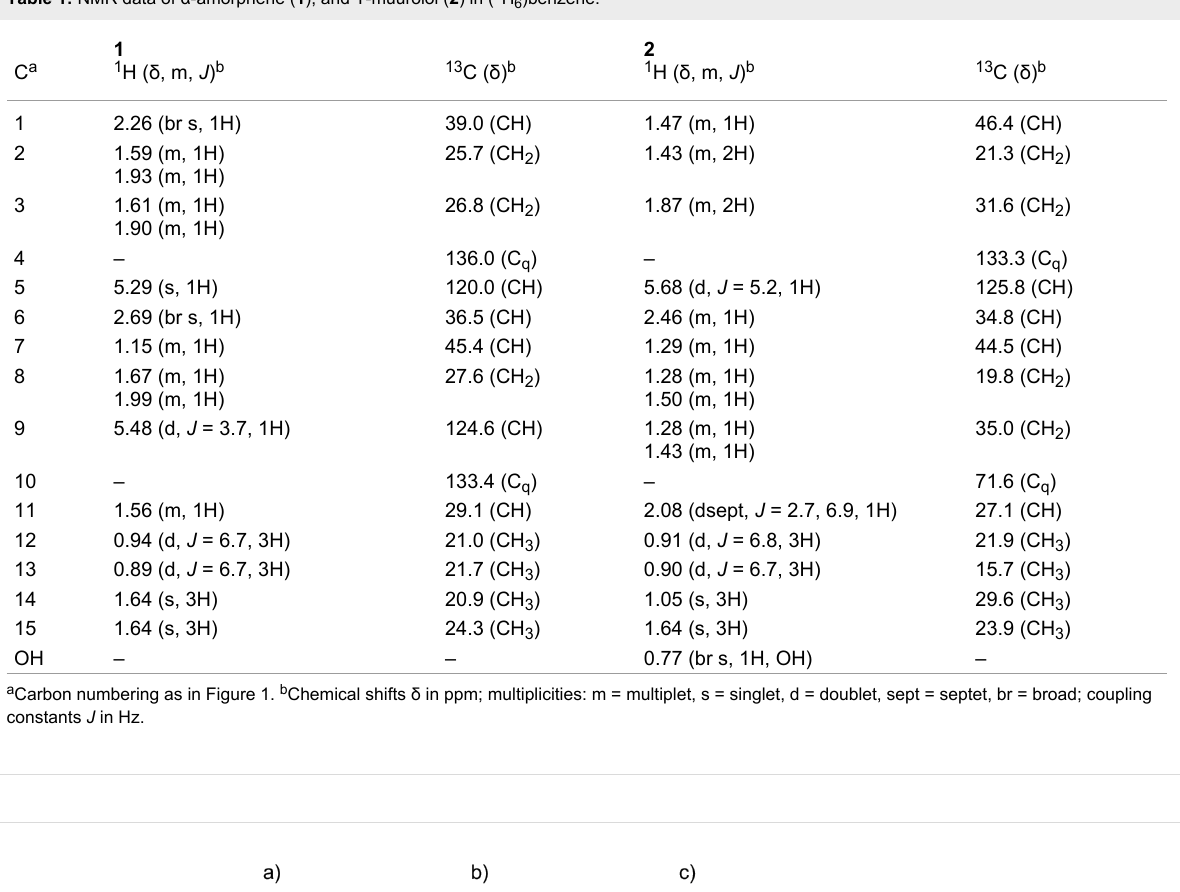
from S. viridochromogenes DSM 40736 displays the aspartate- rich motif ( 105 DDRAE), the NSE triad ( 242 PDLFSAVKE) starting with a proline instead of the usual asparagine, obvi- ously without effect on the enzyme function, the pyrophosphate sensor R-196 and the 327 RY dimer. Terpene cyclases with close